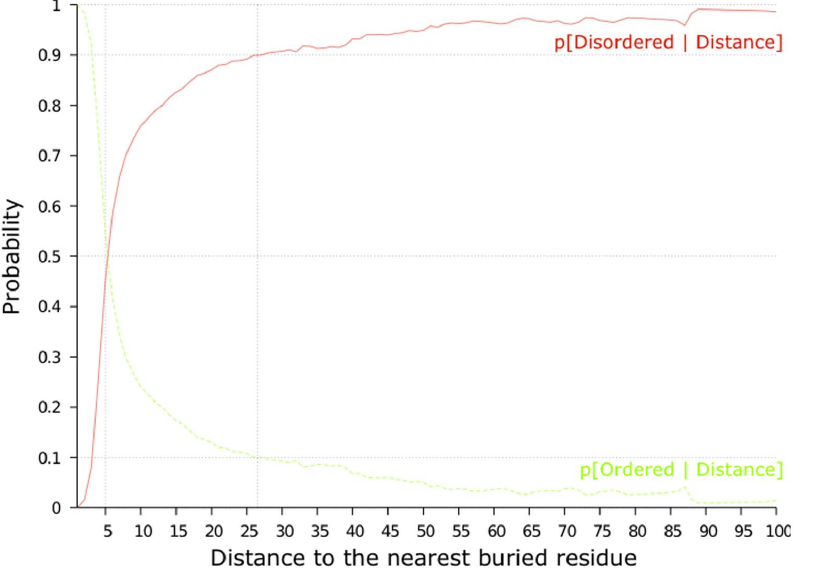
Figure 5. Probability of being (dis)ordered w.r.t. the distance to the nearest buried residue. For a given distance d , the probability p ½ Disorder j d (cid:2) of being disordered is calculated as the portion of disordered residues among the residues that have their nearest buried residue located at a distance d . We computed these curves on the actual values of the solvent accessibility of P DB 30.